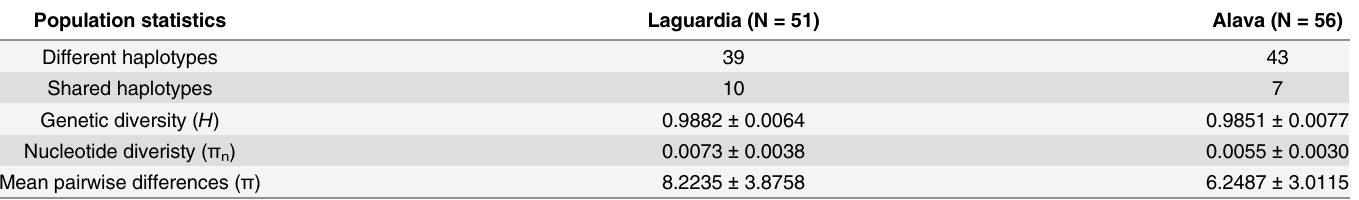
Table 2. Summary of diversity parameters for 51 mtDNA CR (16024 – 576) sequences from Laguardia and 56 from Alava region. Insertions at 16193, 309, and 573 were ignored for all calculations. Population